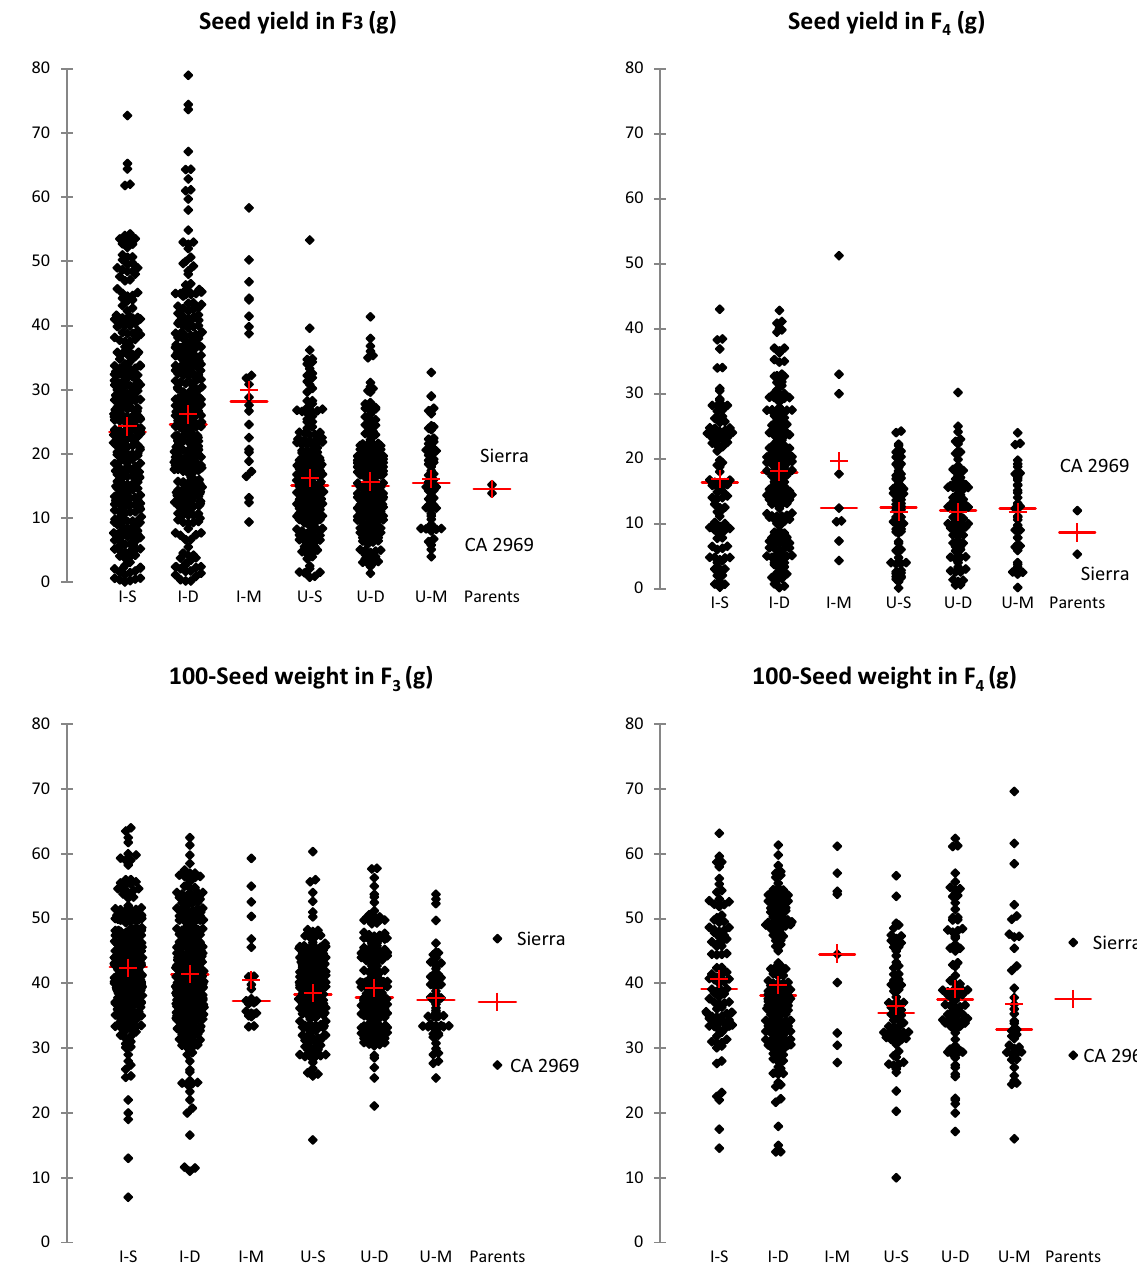
Figure 3. Means (+) of transgressive segregations and superior lines for seed yield per plant and 100-seed weight in F 3 and F 4 populations derived from intraspecific crosses between Sierra and CA 2969. Each dot represents a progeny. I–S: imparipinnate-leafed and single-podded progeny, I–D: imparipinnate-leafed and double-podded progeny, I–M: imparipinnate-leafed and multi-podded progeny, U–S: unifoliolate-leafed and single-podded progeny, U–D: unifoliolate-leafed and double-podded progeny, U–M: unifoliolate-leafed and multi-podded